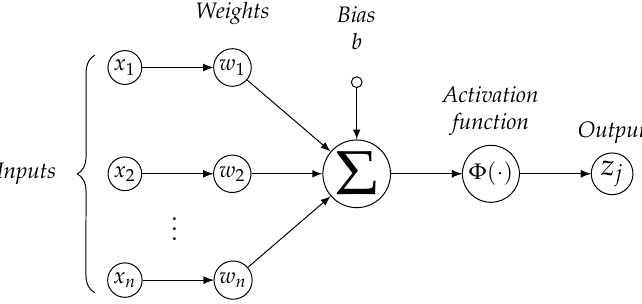
Figure 1. Representation of a node with n input features.